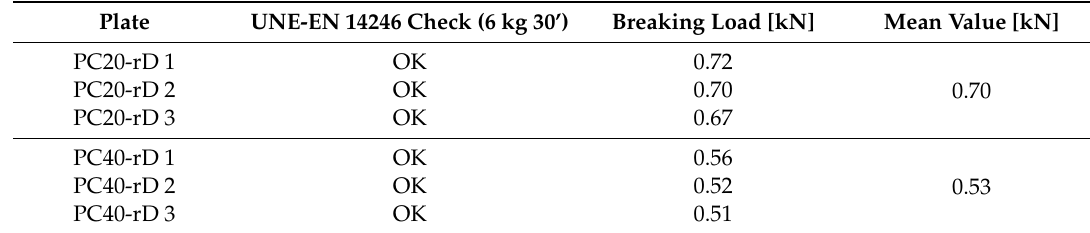
Table 9. Flexural strength test results for the Scenario 3